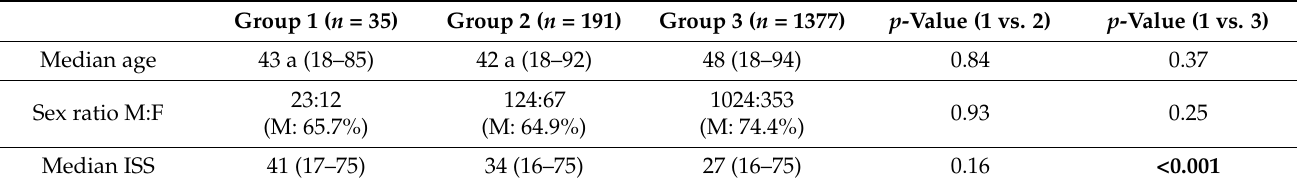
Table 1. Demographic characteristics and ISS.